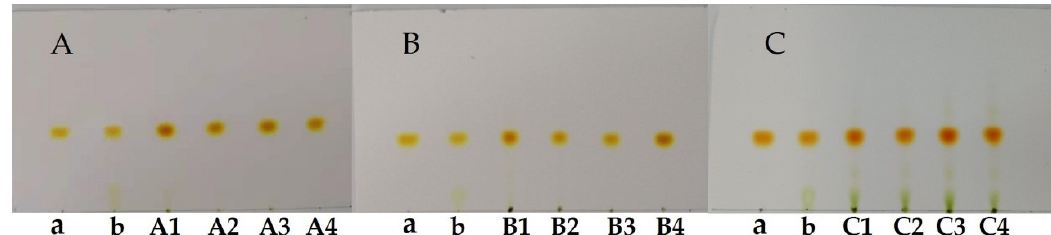
Figure 7. The recovery rate of FX obtained from the solutions A1–A4, B1–B4, and C1–C4.